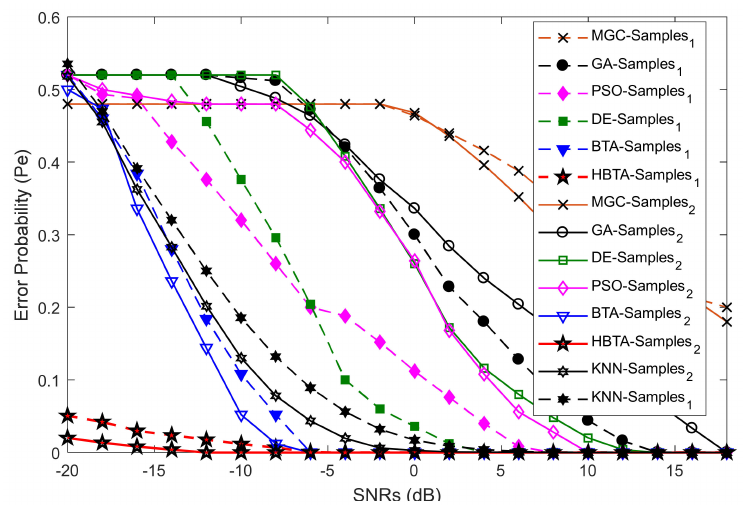
Figure 21. Error probability vs. SNRs in the presence of AO-AOC users with sensing samples 1 (280) and samples 2